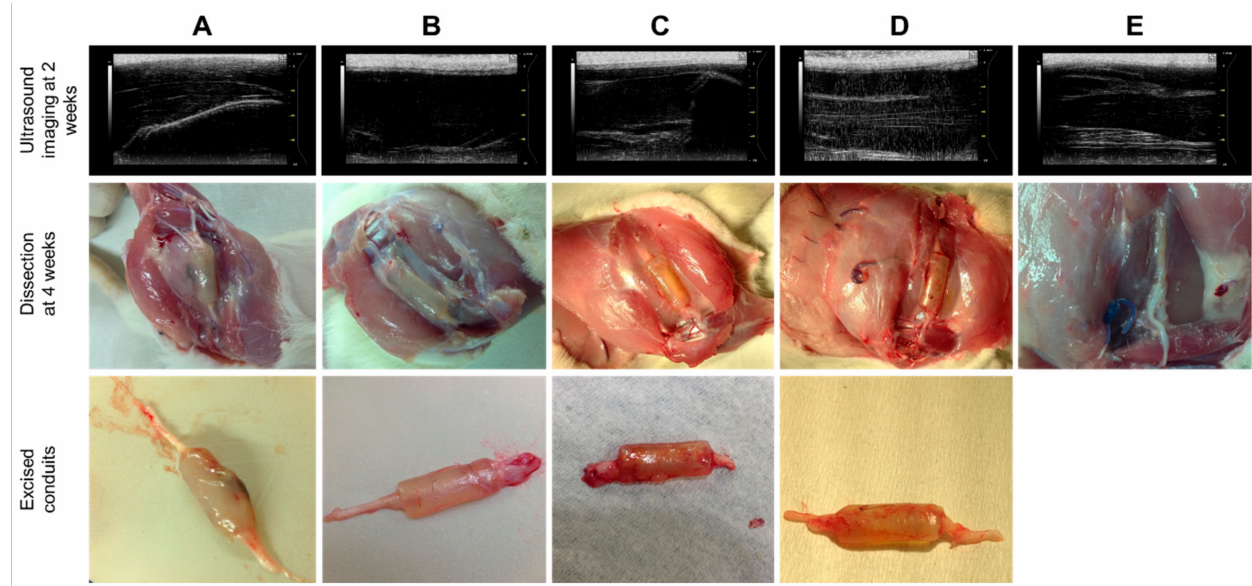
Figure 5. Images of ultrasound analysis, post-implantation and excised conduit of Groups ( A – E ).